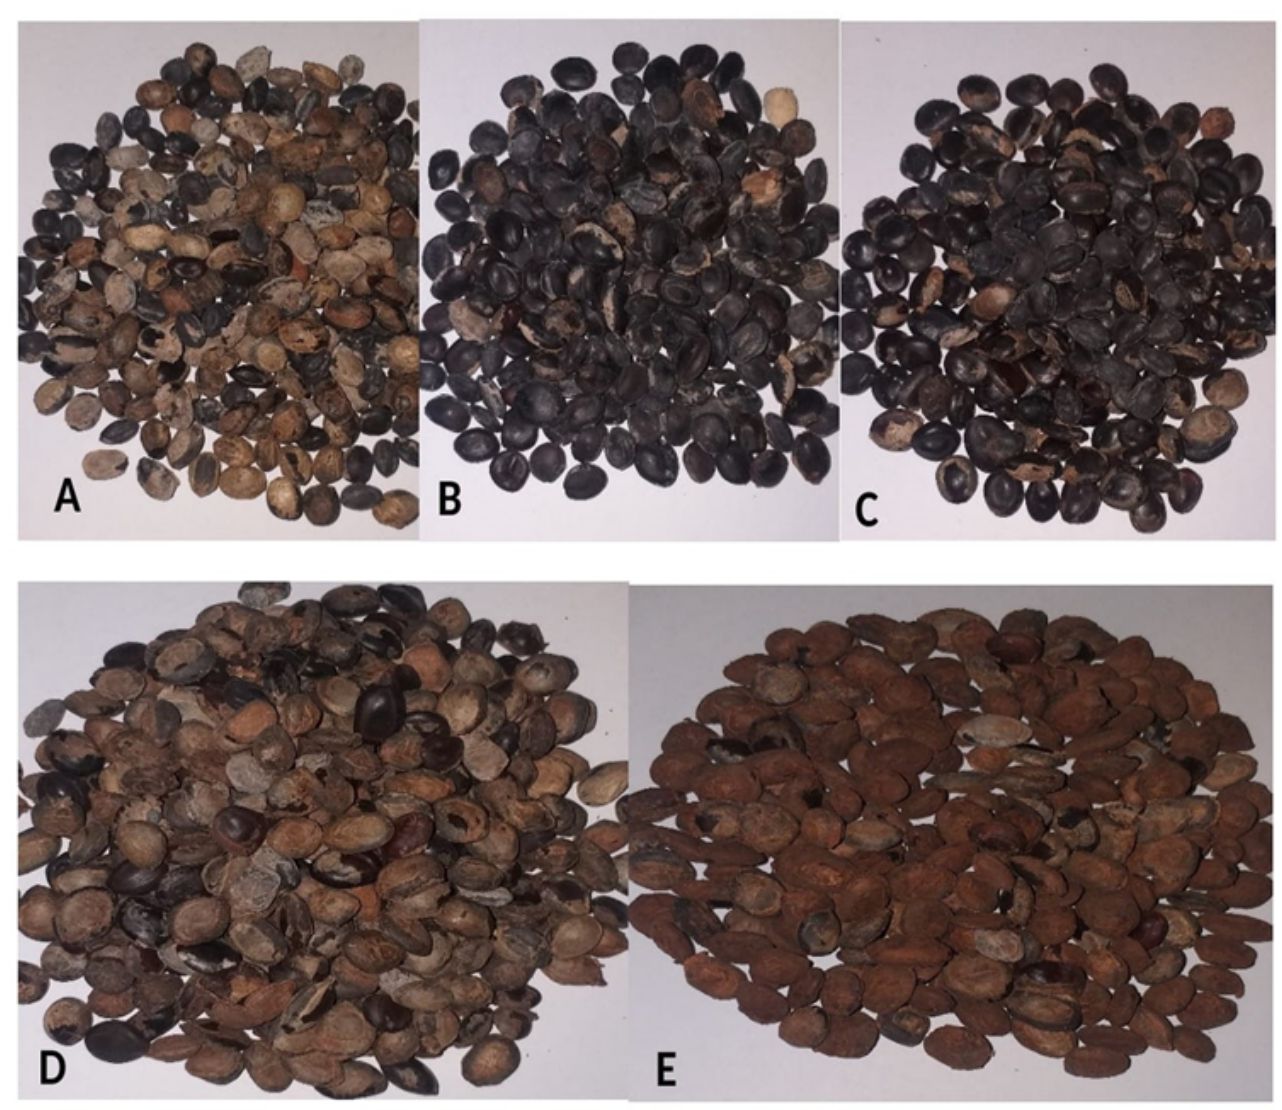
Figure 3. Shapes and colour of seeds with seed coat of Parkia biglobosa : A) Round oval shape (NH/2016/P02), B) Flat oval shape (NH/2016/P03), C) Black colour (NH/2016/P12), D) Brownish black colour (NH/2016/P14), E) Brown colour